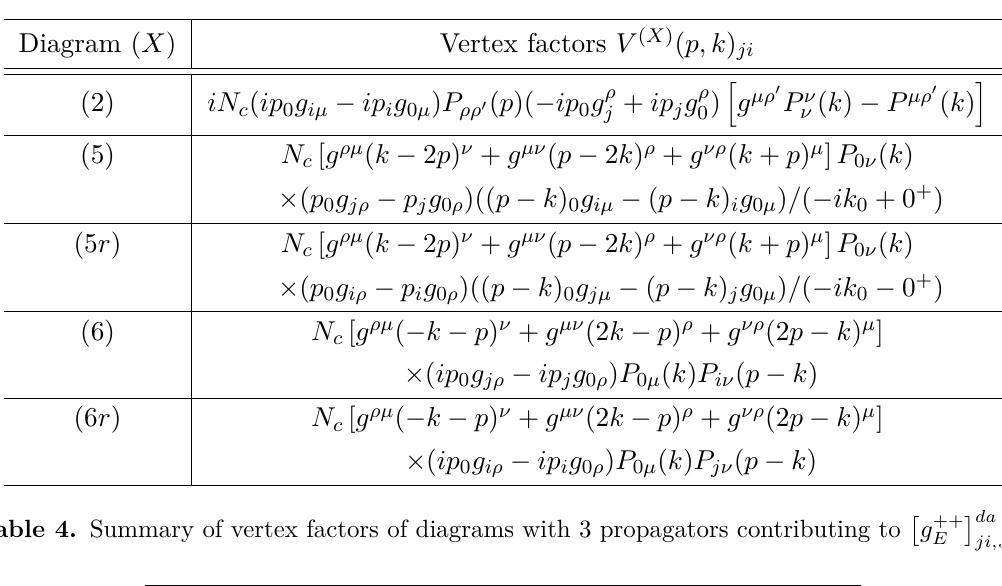
Table 4. Summary of vertex factors of diagrams with 3 propagators contributing to